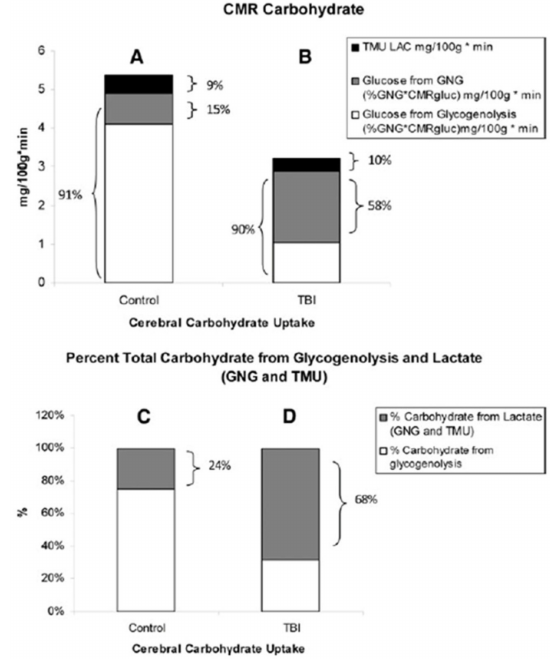
Figure 11. Histograms of the absolute and relative contributions to total cerebral carbohydrate (CHO) from lactate, glucose from gluconeogenesis (GNG), and glucose from hepatic glycogenolysis in healthy control subjects (left, panels A , C ), and traumatic brain injury (TBI) patients (right, panels B , D ). Compared with panel ( A , B ) shows the decrease in cerebral metabolic rate for glucose (CMRgluc) following TBI, but also shows increased contributions of lactate and glucose from GNG to total cerebral CHO uptake after TBI. A comparison of panels ( C ) (control) and ( D ) (TBI) shows the large increase in percentage cerebral CHO uptake contributed by lactate, directly, or indirectly from GNG, following TBI. These figures demonstrate the direct and indirect means by which lactate and gluconeogenesis from lactate support the healthy as well as injured brain. From